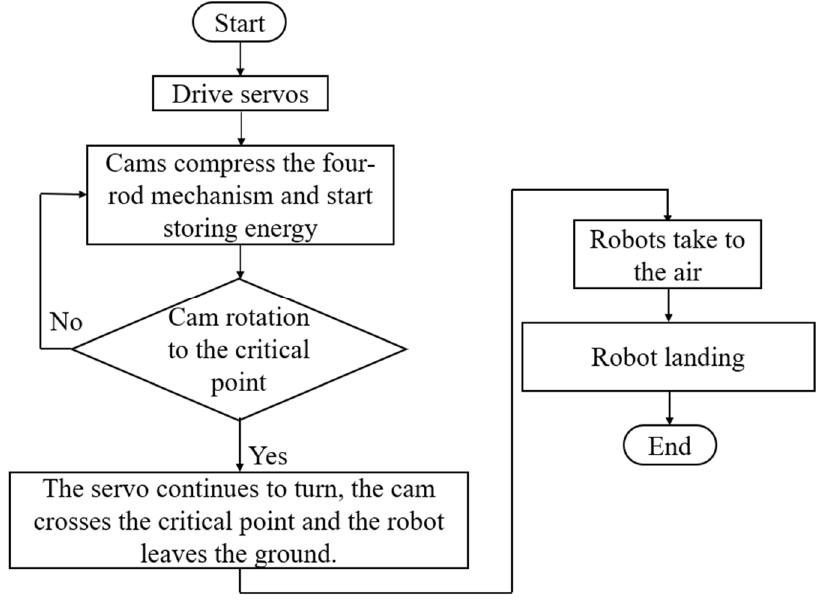
Figure 5. Bouncing movement flow chart.